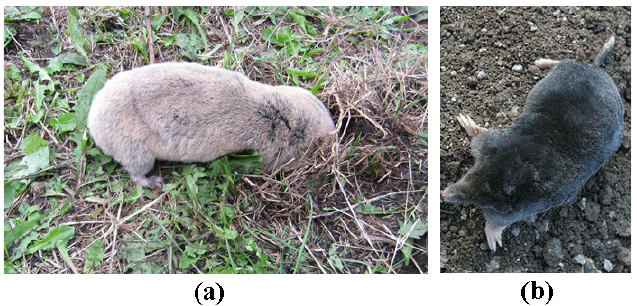
Figure 2. Photo of subterranean mammals in Mordovia: ( a )— Spalax microphthalmus , ( b )— Talpa europaea . Photographs by A. Andreychev.